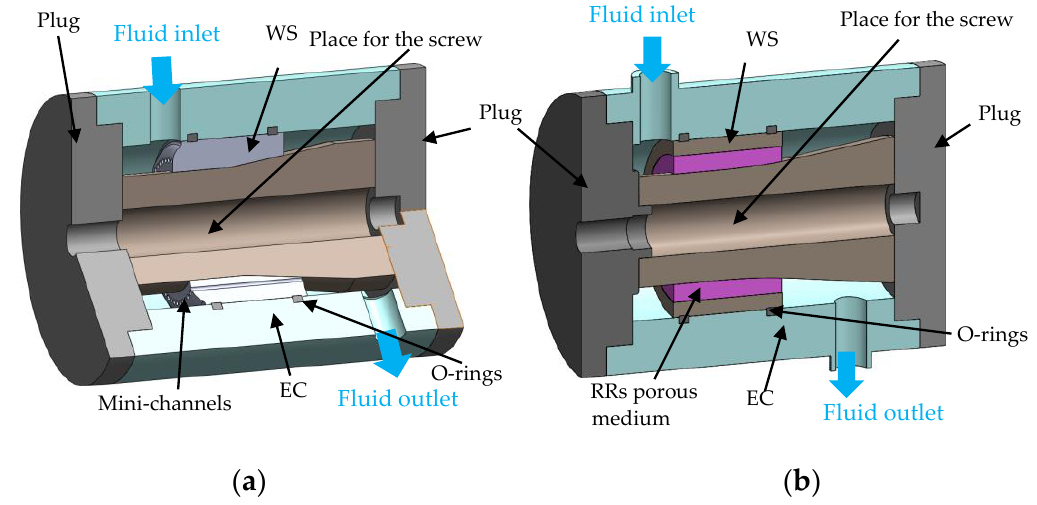
Figure 2. CAD sections of the mock-up equipped with mini-channels ( a ) and with Raschig rings ( b ).